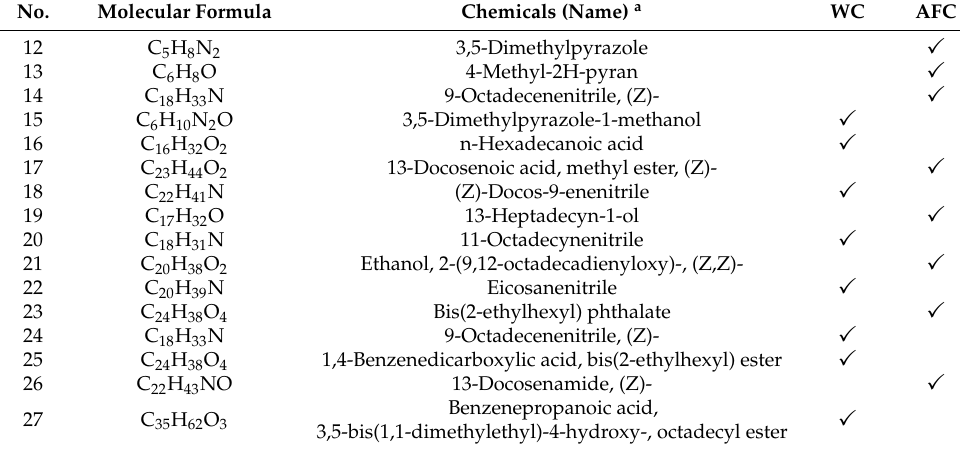
Figure 9. Solid-state 13 C NMR spectra of WC and AFC samples.